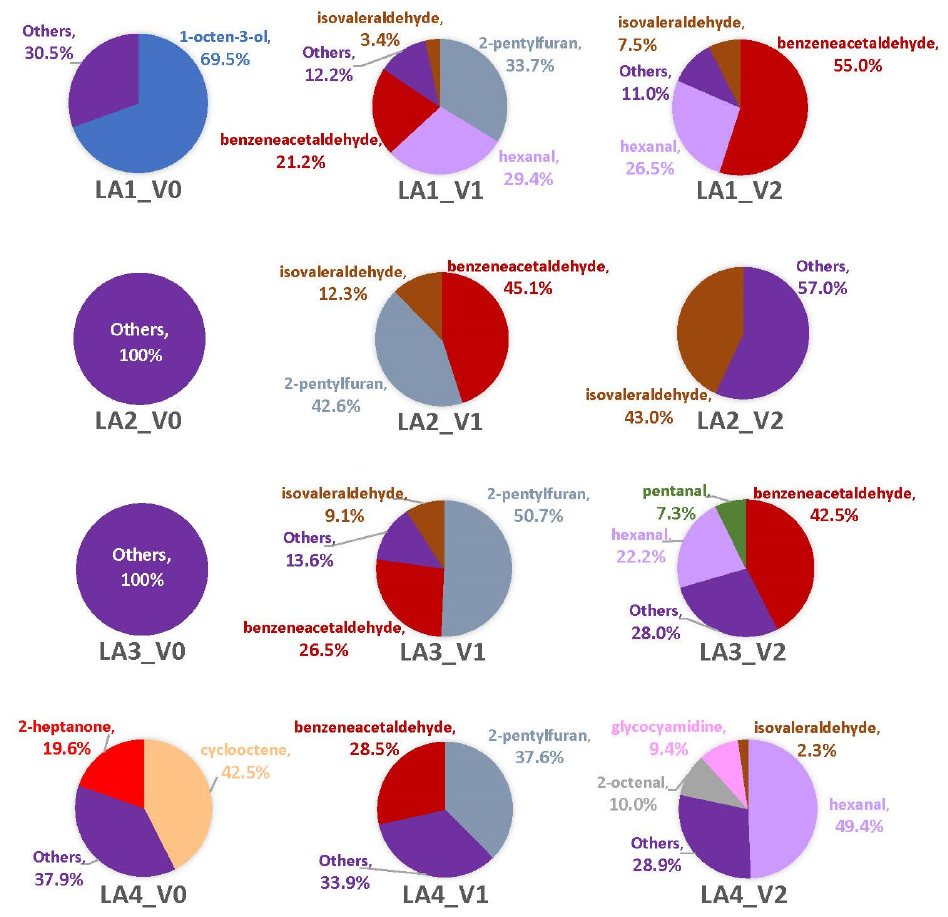
Figure 5. Average percentages (over three replicates) of VOCs contributing to total headspace profile of each Aspergillus strain while growing on cracked kernels of VA35, an A. flavus -susceptible variety of corn, at each of three sampling time points (48 h, one week, and two weeks).